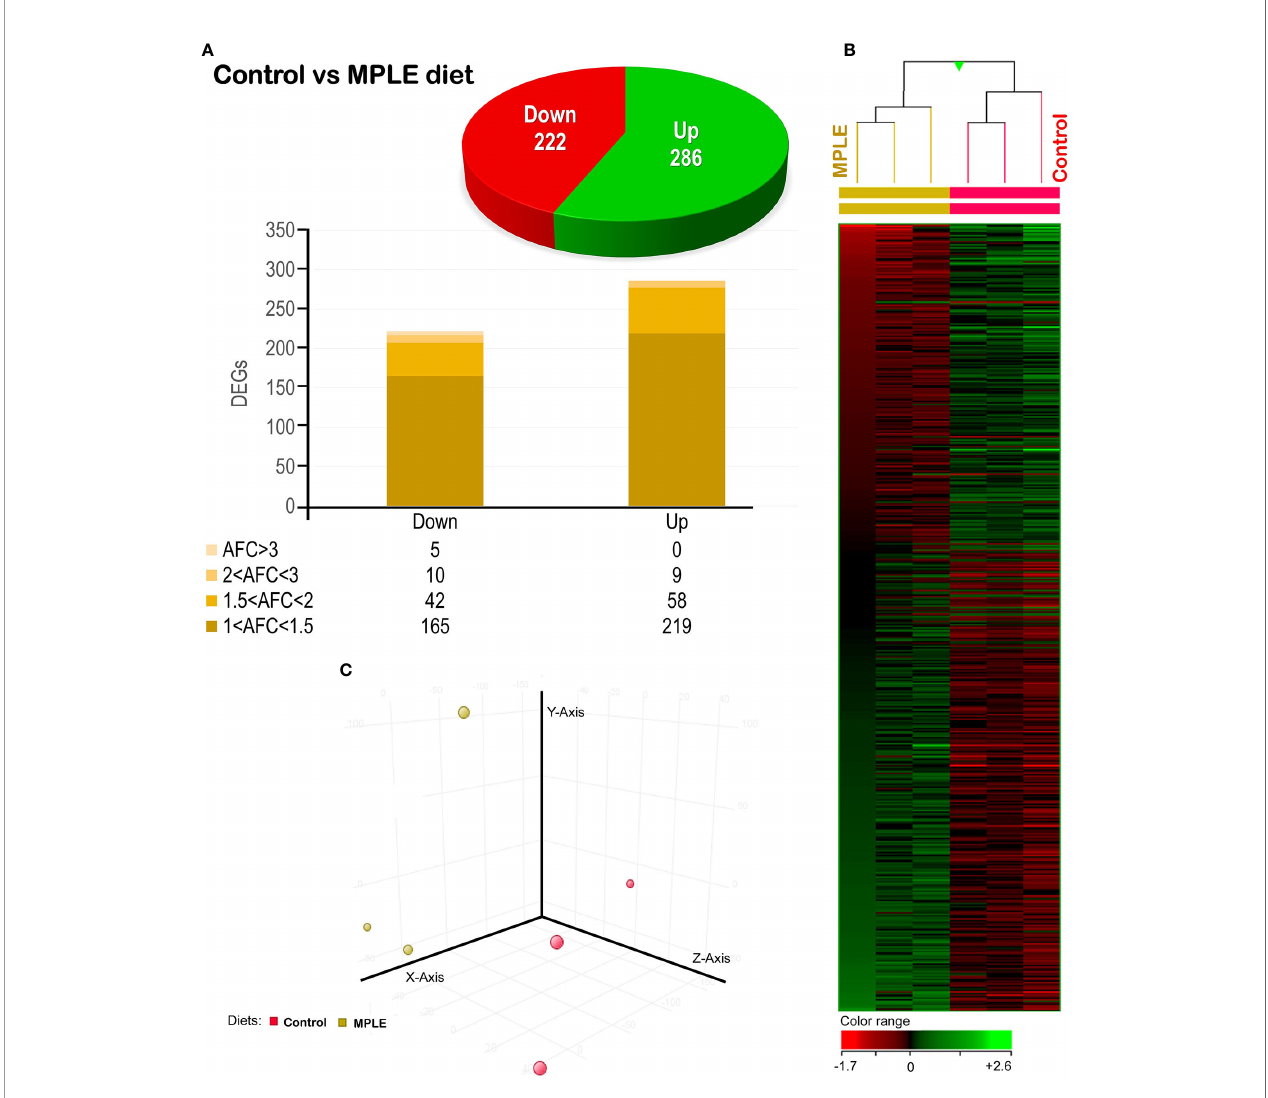
FIGURE 4 | Differential expression analysis of the gilthead seabream ( Sparus aurata ) mid-anterior intestine transcriptomic response to MPLE diet. (A) Distribution of the differential expressed genes (DEGs) obtained from the microarray-based transcriptomic analysis. The absolute fold change (AFC) indicates the fold-change magnitude interval of response. (B) Hierarchical clustering of the gilthead seabream mid-anterior intestine transcriptomic response for the control and MPLE diet, based in similitude patterns of the differentially expressed genes (DEGs) detected from three sample pools per dietary group. Data of the six microarrays are depicted, one for each representing the pooled RNA. Genes from each replicate are ordered from lower to higher AFC intensities using the left sample (randomly chosen) as a reference for ordering the other fi ve samples (GeneSpring version 14.5 GX software; Agilent Technologies). Both increased and decreased gene expression pattern is shown in green and red, respectively, according to the color range (bottom). All transcripts represented are statistically signi fi cant ( P < 0.05). (C) Principal component analysis (PCA) of the DEGs for the gilthead seabream intestine in response to the control (yellow node) and MPLE-supplemented diet (red node). The MPLE included in the basal diet was obtained from sage ( Salvia of fi cinalis ) and lemon verbena ( Lippia citriodora